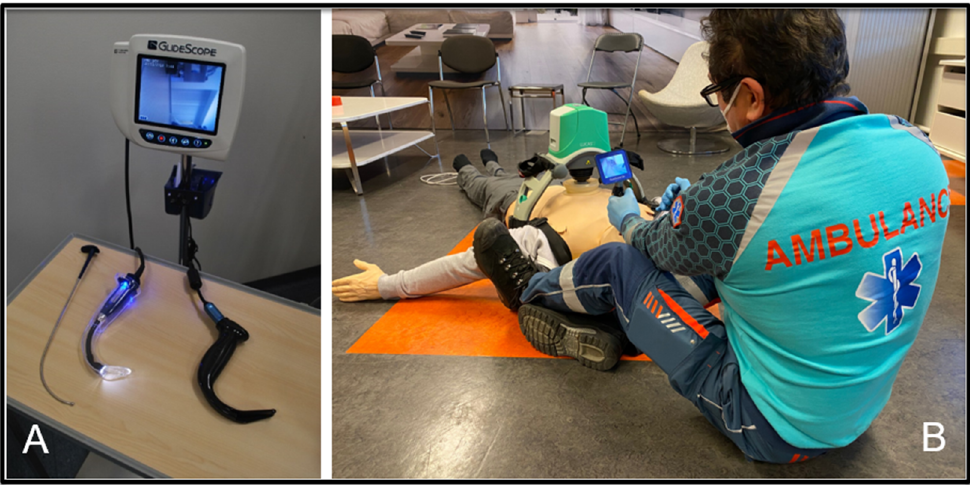
Figure 1. ( A ) The Glidescope ® videolaryngoscope with the former GVL blade ( left ) and recent LoPro blade ( right ), and the Gliderite ® rigid stylet. ( B ) The portable GlidescopeGo ® , used by an EMS clinician in a simulated prehospital advanced life support setting.